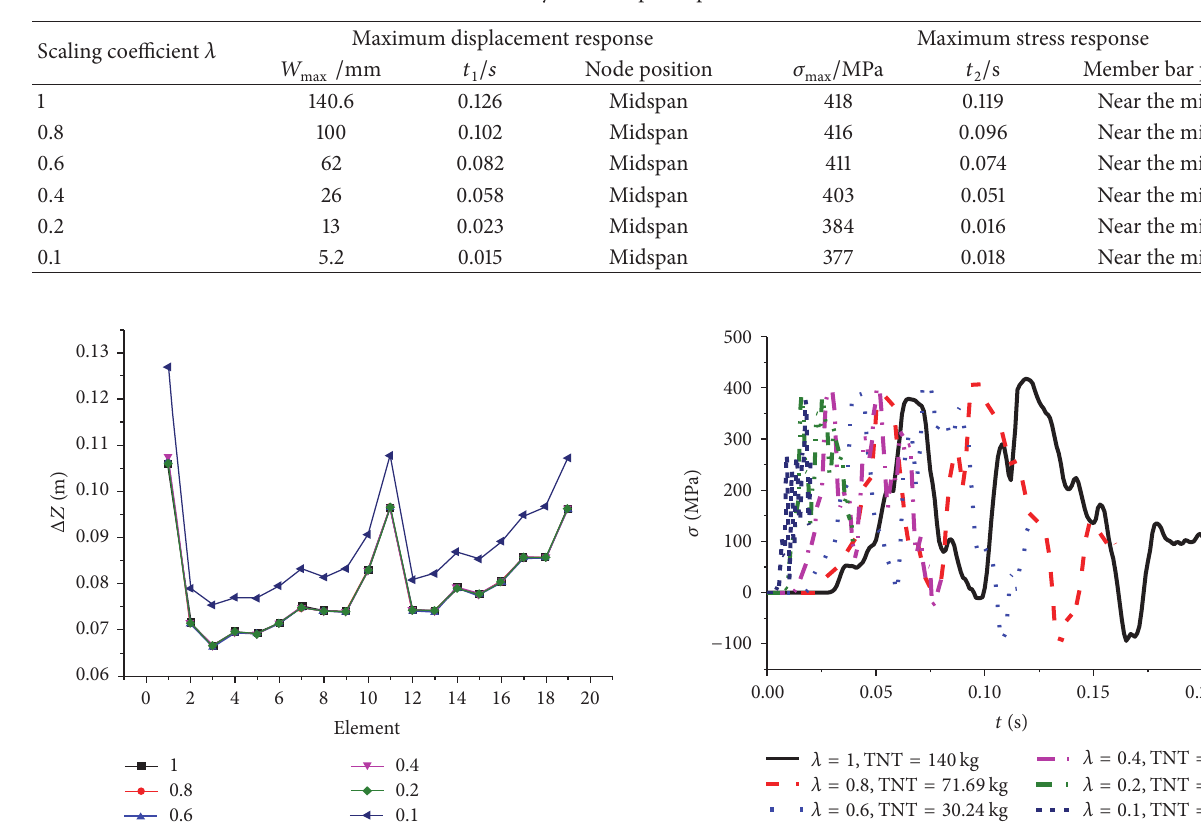
Table 3: Maximum dynamic response positions of each scale model.